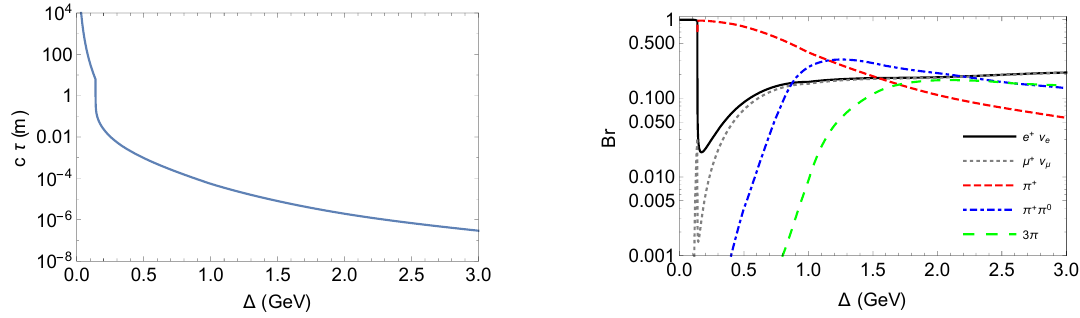
Figure 2 . The lifetime (left) and branching ratios (right) for the triplet decay + ! (cid:31) + SM , as a function of the mass splitting (cid:1). As discussed in the text, all other decay widths are simple rescalings of this one, and the branching ratio is a universal